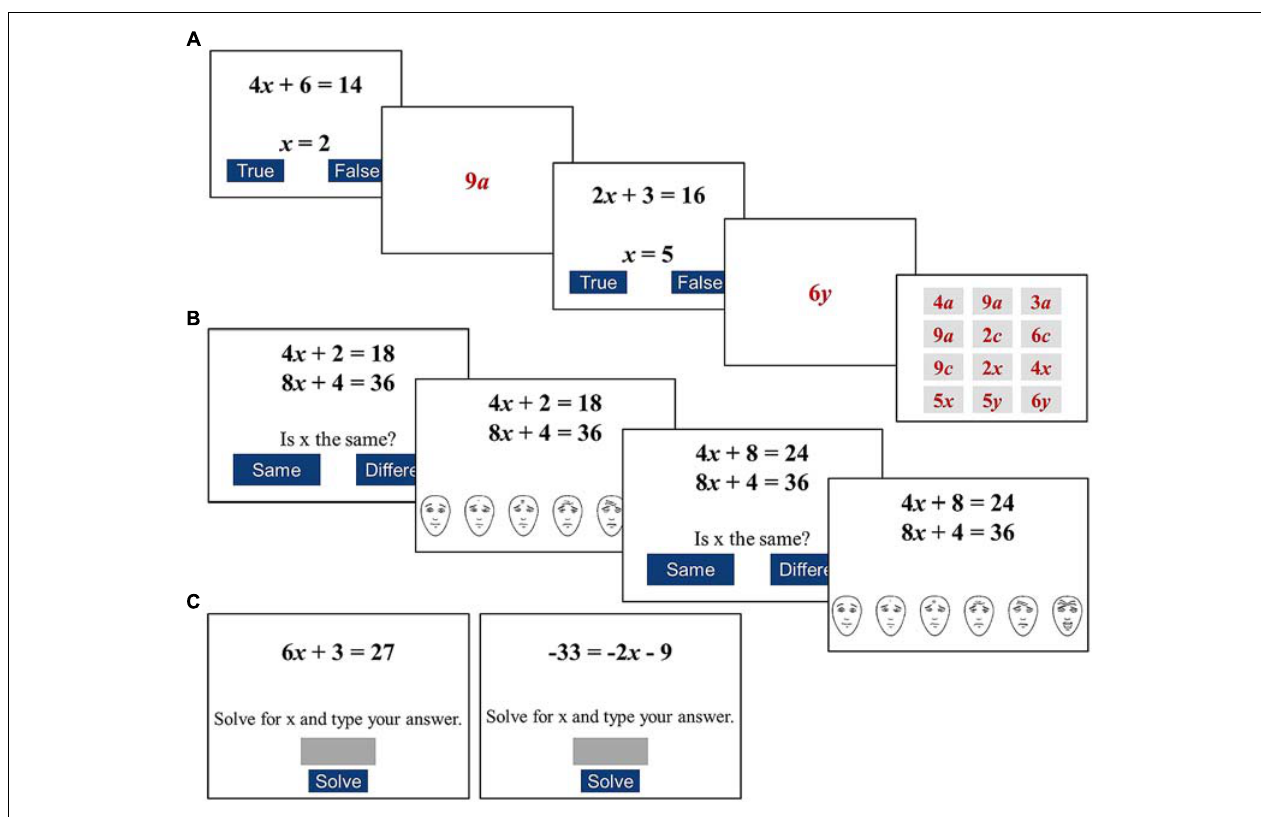
FIGURE 2 | Example stimuli for the (A)WM, (B) worry, and (C) problem solving tasks. A two trial sequence on the algebraicWM task is depicted: two trials each containing a processing (correct/incorrect) and memory (algebraic term) phase, and memory terms on a recognition screen. Algebraic